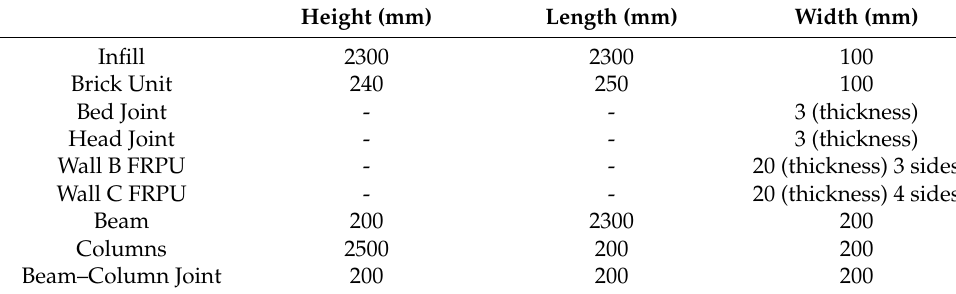
Table 3. Dimensions of structure and of different parts.